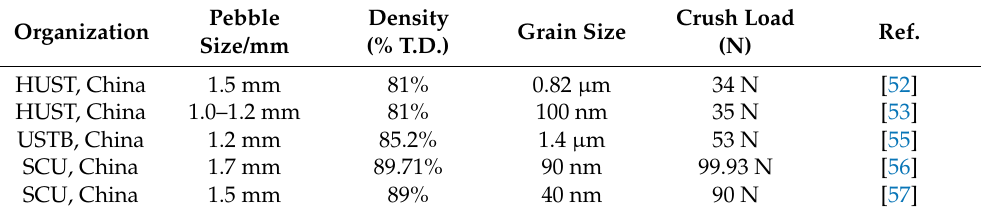
Table 4. Recent developments in the fabrication of Li 2 TiO 3 by hydrothermal